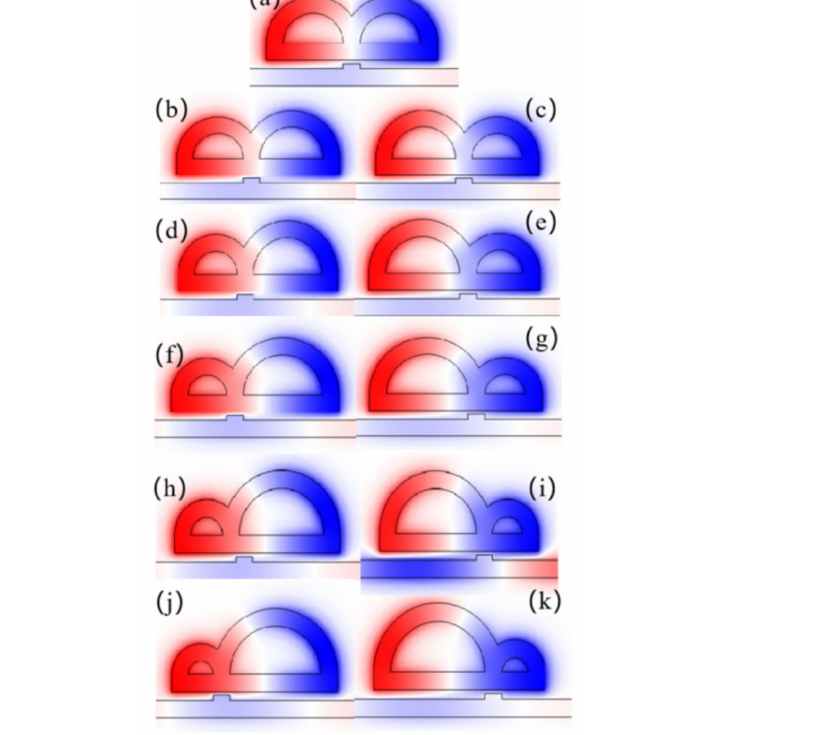
Figure 5. The magnetic field distribution H Z at the Fano resonance dip of ( a ) ∆ R = 0 nm at λ = 1500 nm; ( b , c ) ∆ R = − 20 and 20 nm at λ = 1502 nm; ( d , e ) ∆ R = − 40 and 40 nm at λ = 1506 nm; ( f , g ) ∆ R = − 60 and 60 nm at λ = 1512 nm; ( h , i ) ∆ R = − 180 and 180 nm at λ = 1515 nm; ( j , k ) ∆ R = − 100 and 100 nm at λ = 1530 nm.